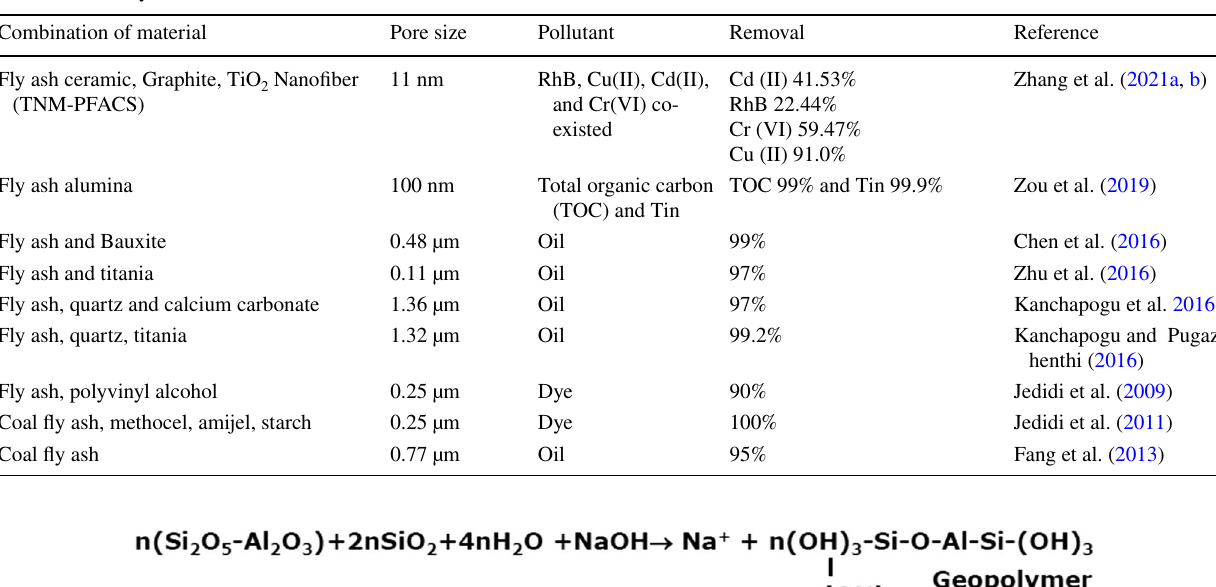
Table 12 Coal fly ash derived membrane Combination of material